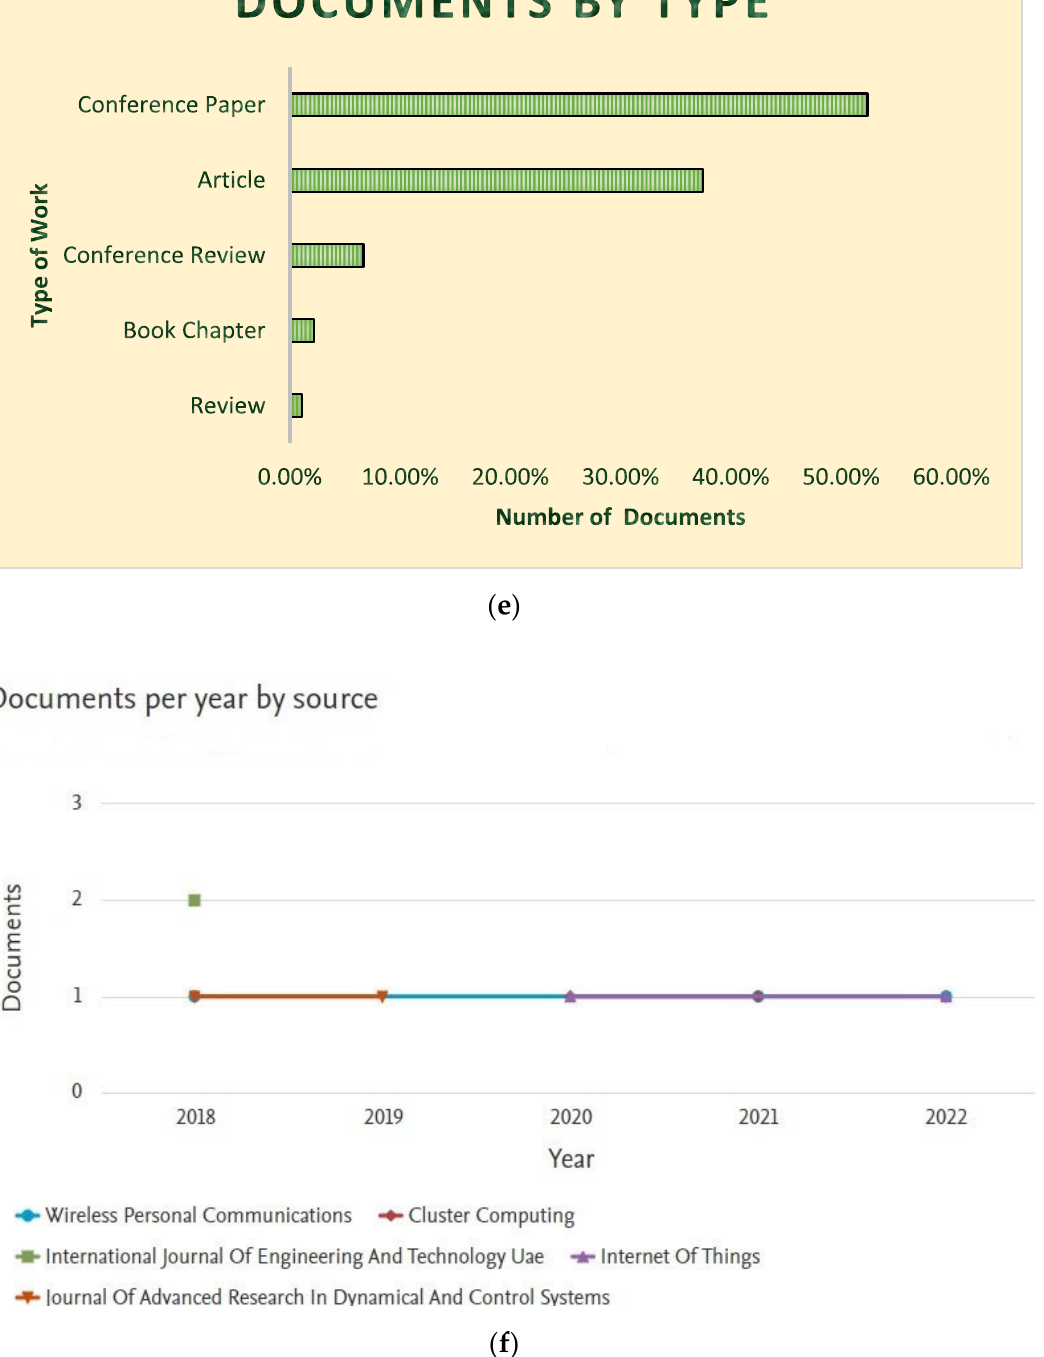
Figure 9. ( a ): The authors and cumulative numbers of research articles related to SDN controllers. ( b ): The affiliation and cumulative numbers of research documents related to SDN controllers. ( c ): The country and cumulative numbers of research documents related to SDN controllers. ( d ): The annual and cumulative numbers of research documents related to comparison SDN controllers. ( e ): The type of work and cumulative numbers of research documents related to SDN controllers. ( f ): The annual with source and cumulative numbers of research documents related to SDN controllers.